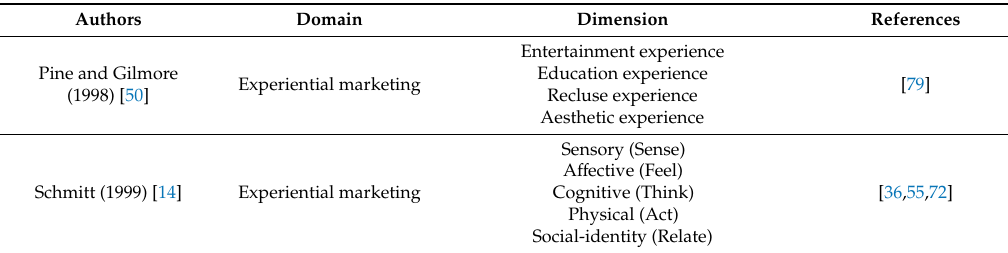
Table A2. Dimension of customer